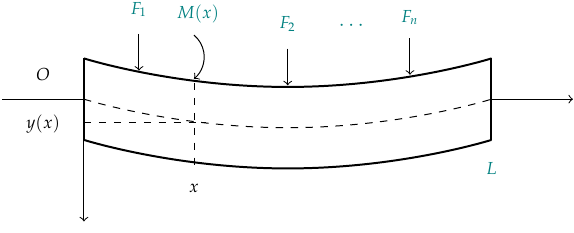
Figure 1. The elastic curve y ( x ) .